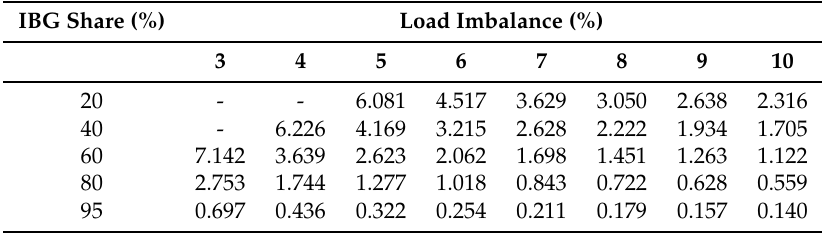
Table 6. Critical time for European-scale case given in seconds.